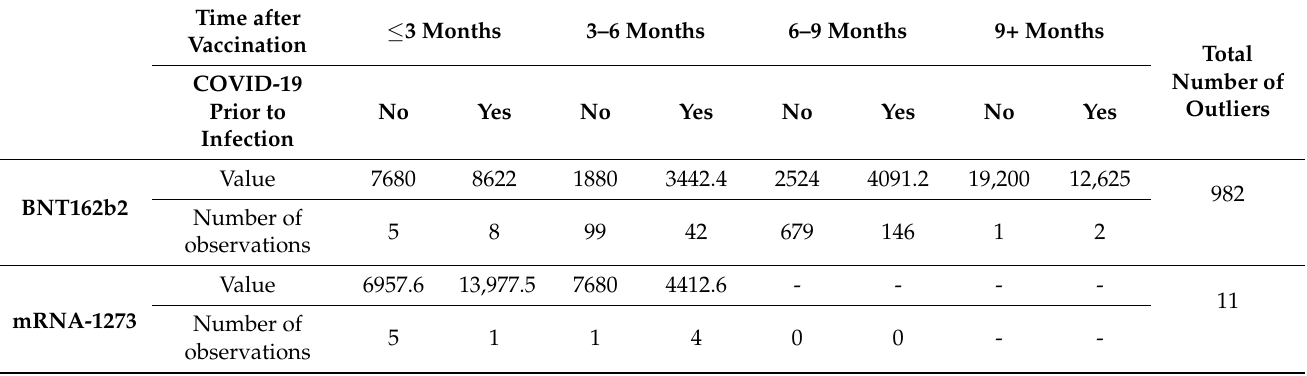
Table 2. Minimal values and the numbers of outliers for each group determined by the time after vaccination and COVID-19 prior infection for BNT162b2 and mRNA-1273. Time after